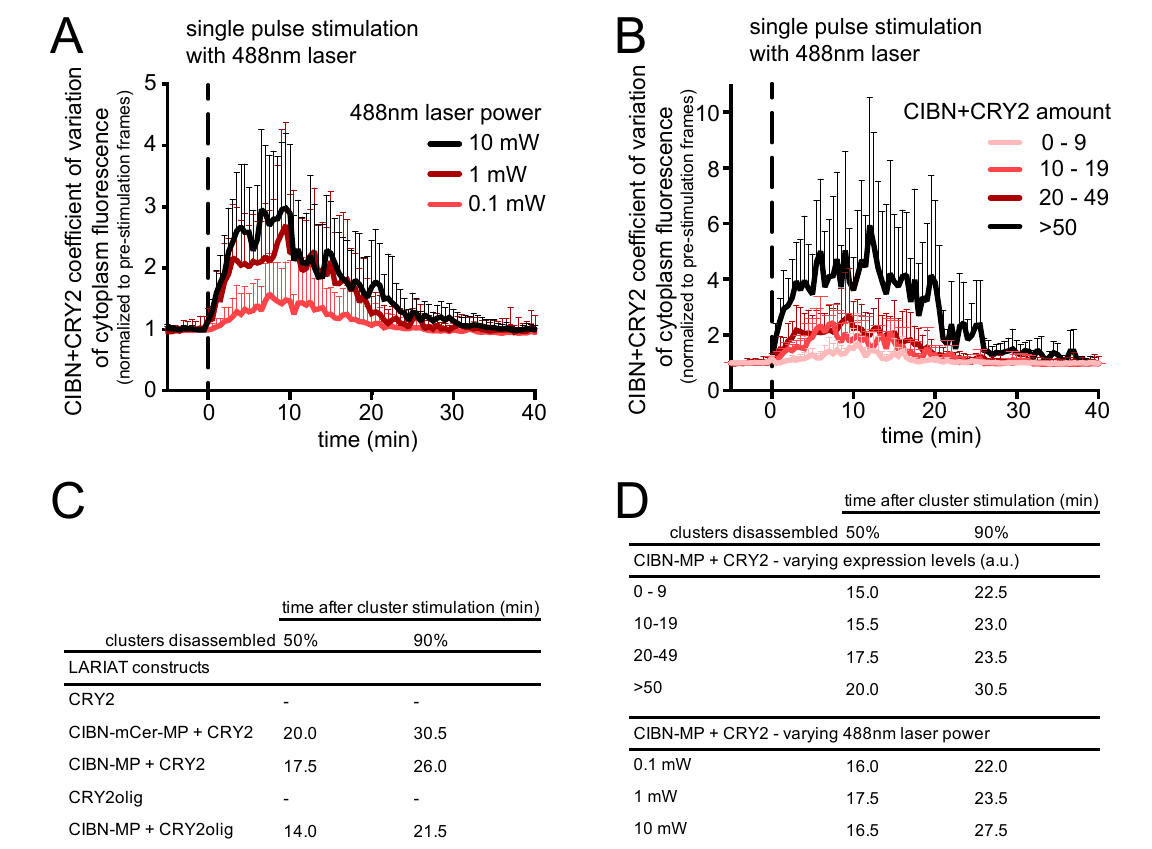
Figure A1. Laser intensity and LARIAT expression levels affect LARIAT clustering. Drosophila S2 cells expressing CIBN-MP and RFP-CRY2-V H H were analyzed through live-imaging as in Figure 3. ( A ) LARIAT clustering was stimulated with a 488 nm laser set to the indicated laser power for 300 ms at minute 0. Clustering was quantified with the coefficient of variation of cytoplasm fluorescence. Graph displays mean ± SD. n > 10 cells expressing between 20 and 49 relative amount of CIBN-MP + RFP-CRY2-V H H for each laser condition. ( B ) Cells exposed to 1 mW 488 nm laser power in ( A ) were grouped according to the CIBN-MP and RFP-CRY2-V H H expression level measured through average fluorescence intensity in the cytoplasm in the frames prior to the clustering stimulation. Graph displays mean ± SD. n (0–9) = 4 cells, n (10–19) = 4 cells, n (20–49) = 12 cells, n (50+) = 4 cells. Timepoint at which clustering reversal reaches 50% and 90% of maximum clustering, which was estimated after smoothing curves plotted in Figure 3B ( C ) and Figure A1A,B ( D